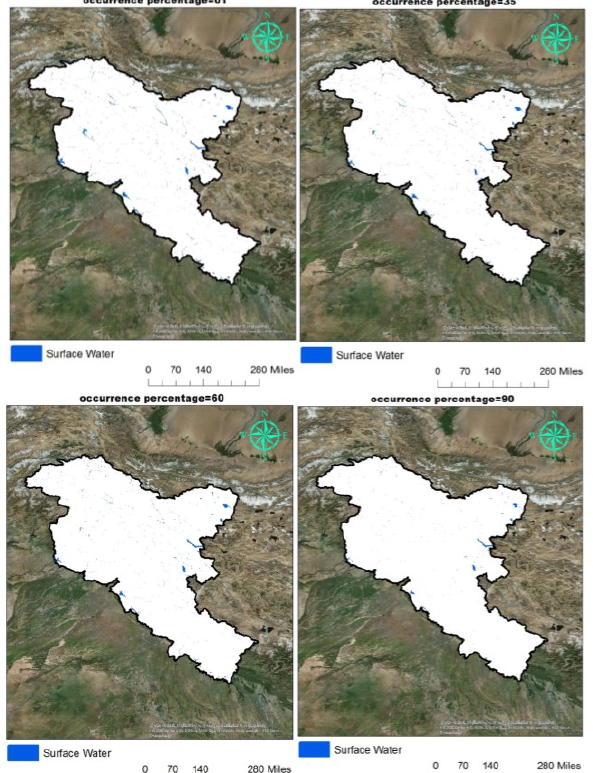
Figure 9. Surface water occurrence (%) of NWH from 1984 to 2015 at 01, 35, 60 and 99 percentage levels. Higher the occurrence percentage, more perennially or permanent the water